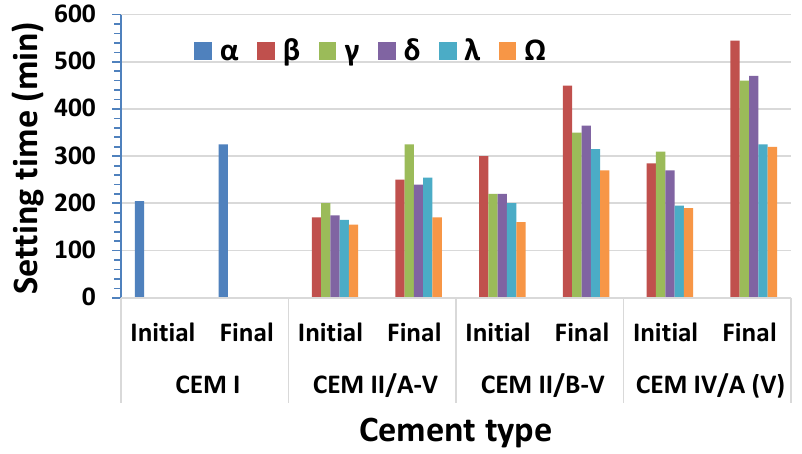
Figure 6. Coal ash cement paste properties: water demand for normal consistency.